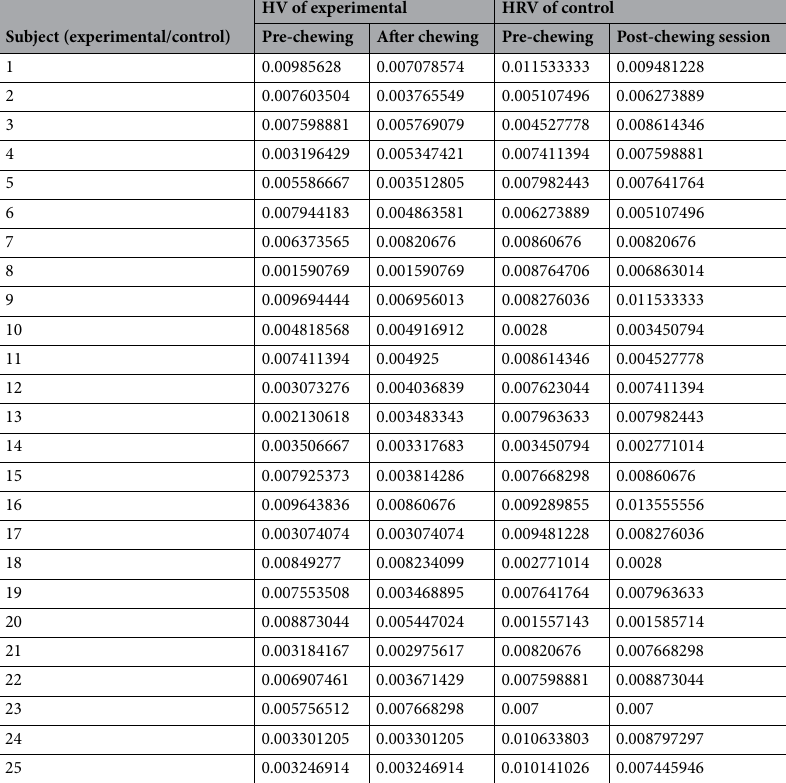
Table 1. Sample measurement results of HRV of the 25 experimental and control subjects, pre- and post- chewing sessions.